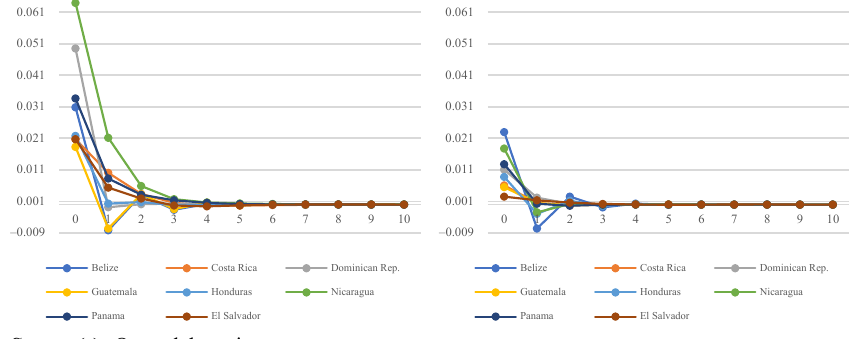
Figure 1. Domestic shocks in CAC, 1960 – 2000 (left), 2001 – 2018